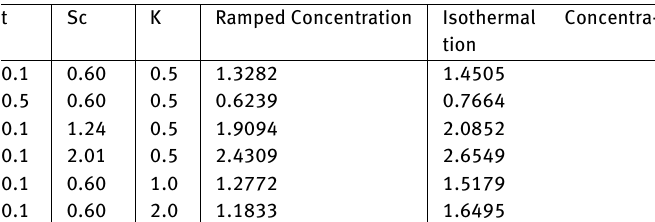
Table 5: Sherwood number